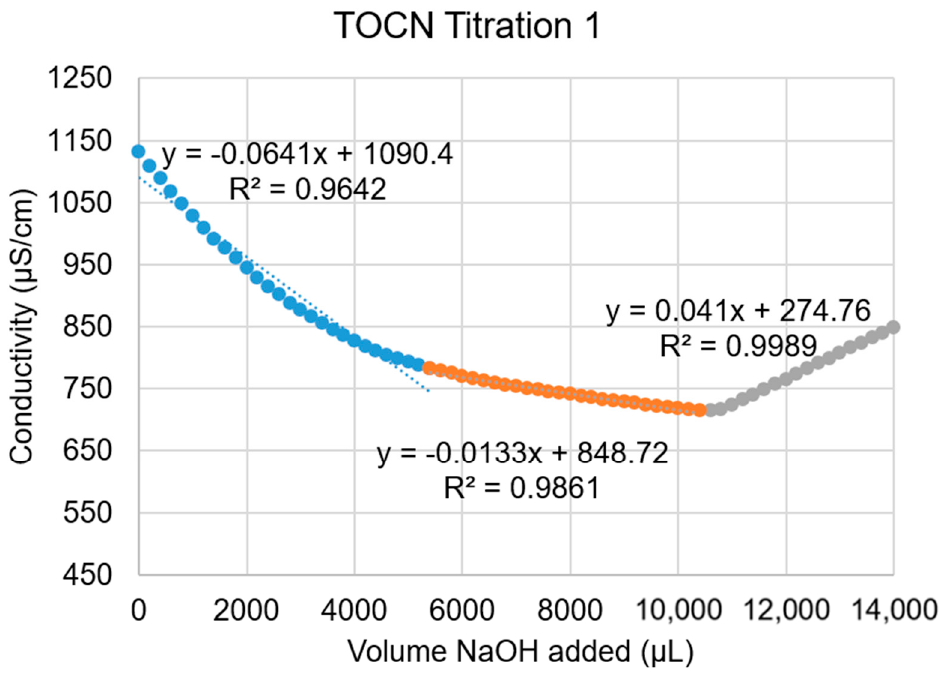
Figure A1. Conductivity vs. volume NaOH added for the first TOCN titration.